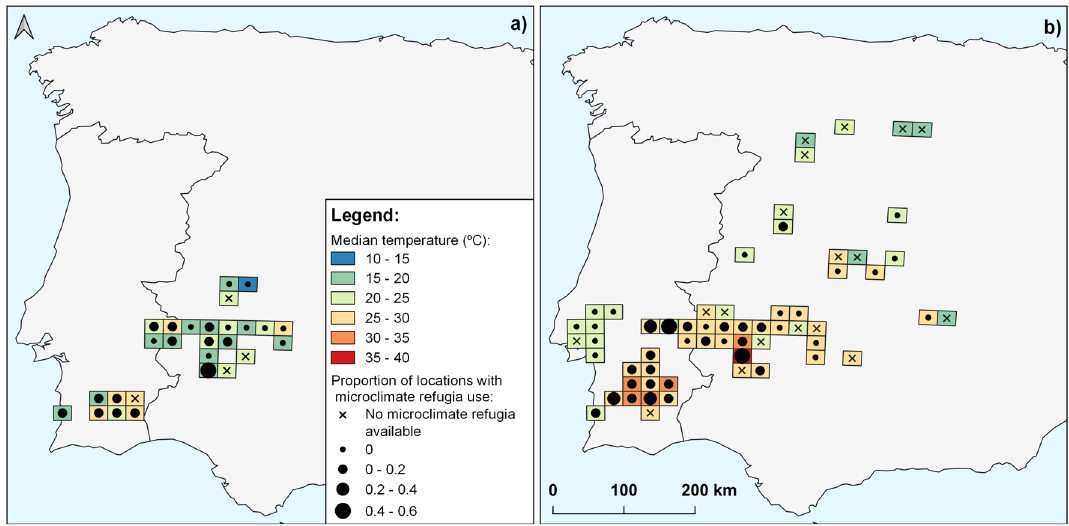
Figure 2. Mean median temperature for little bustard locations in the 25 × 25 km grid cells occupied and proportion of locations where microclimate refugia was used by little bustards (circles), in both a) breeding and b) post-breeding seasons. The “x” shows the grids were there was no microclimate refugia available. Map made with QGIS 3.28.2 (www. qgis.